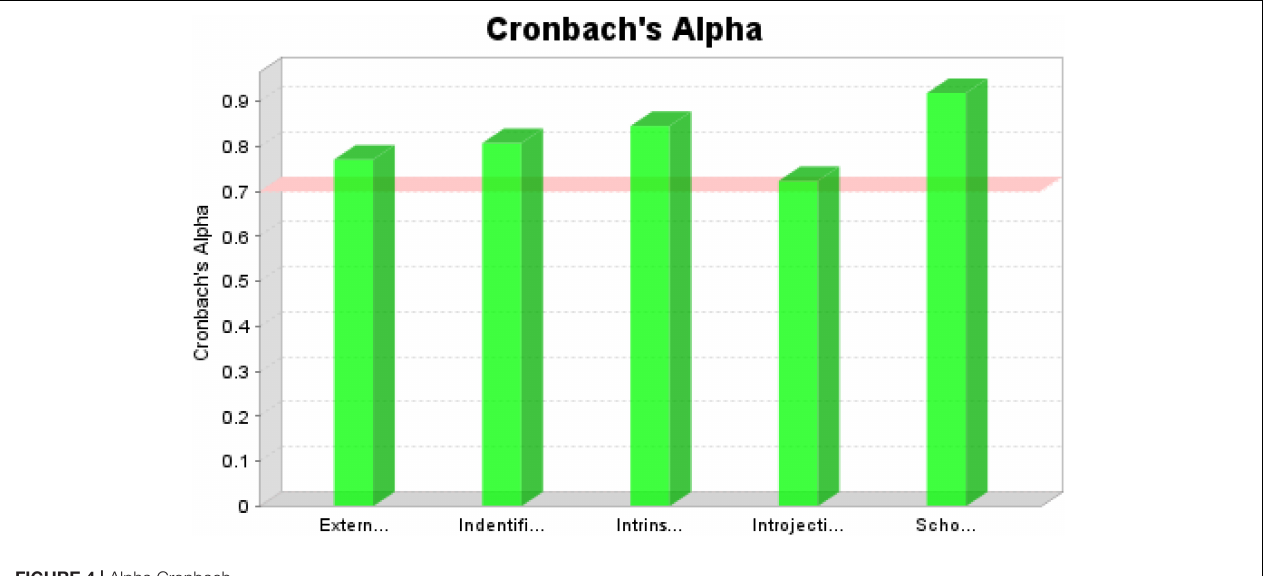
FIGURE 4 | Alpha Cronbach.